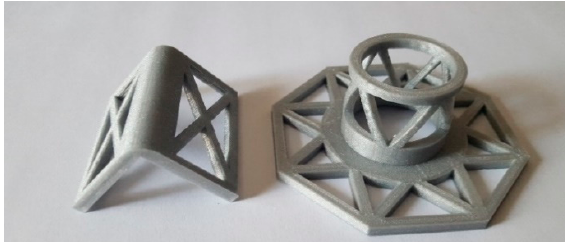
Figure 22. 3D printed funnel plates and rounded angles.